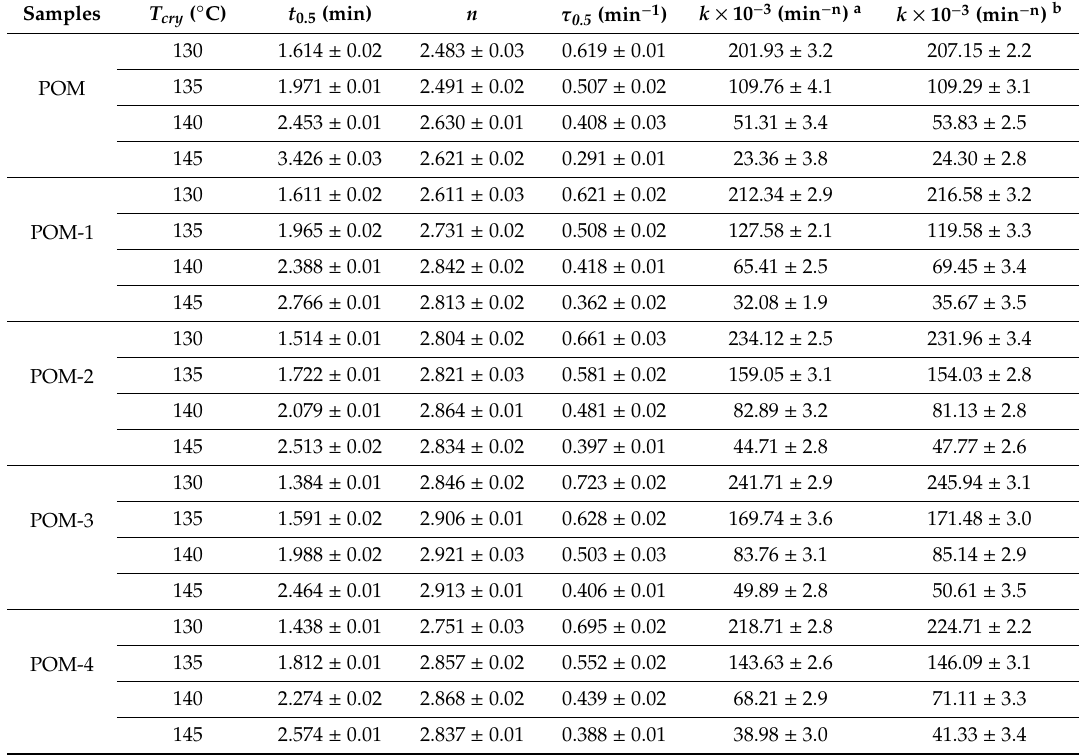
Table 4. Parameters of Avrami analysis for POM / Ag